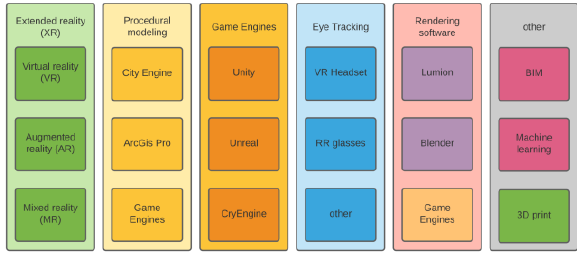
Figure 1 . Overview of technologies and their software